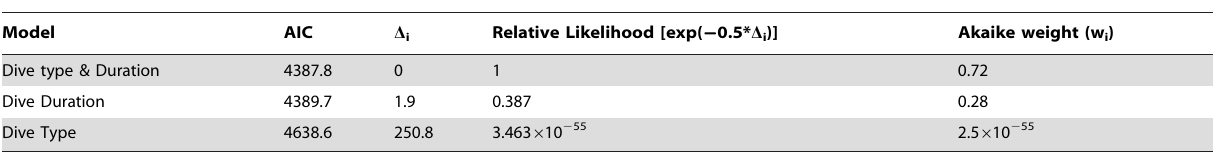
Table 2. Model selection